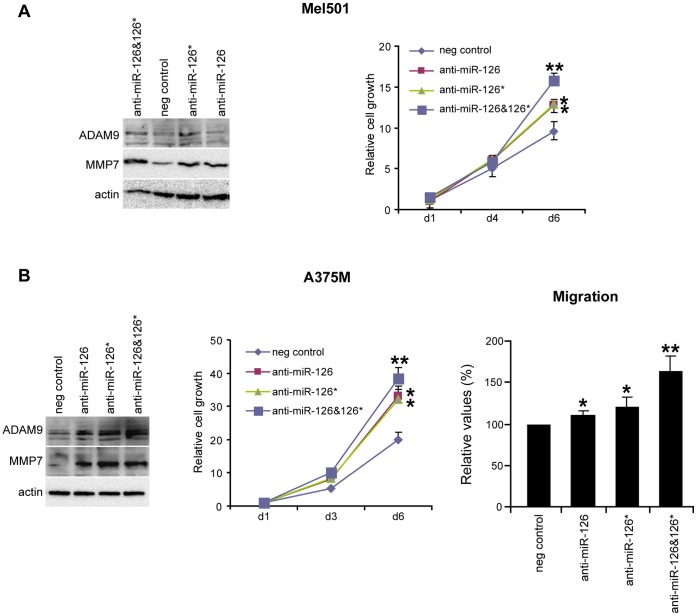
Effects of miR-126&126* knockdown evaluated in Mel501 primary and A375M metastatic melanoma cell lines.
A) Representative WB analysis of ADAM9 and MMP7 target genes (left); cell growth proliferation analysis (right). B) WB analysis of ADAM9 and MMP7 (left), cell growth proliferation (middle) and migration (right). Actin was utilized as internal loading control.